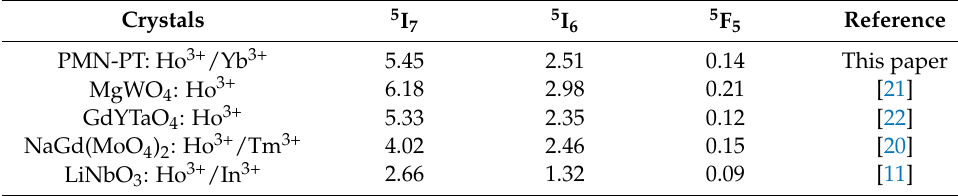
Table 5. The radiative lifetimes of Ho 3+ in different